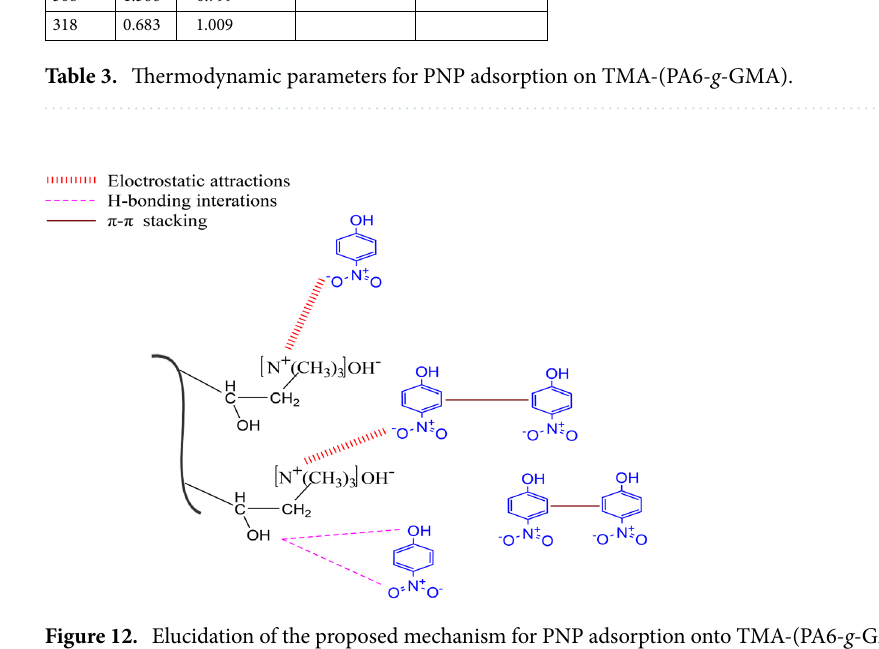
Figure 12. Elucidation of the proposed mechanism for PNP adsorption onto TMA-(PA6- g